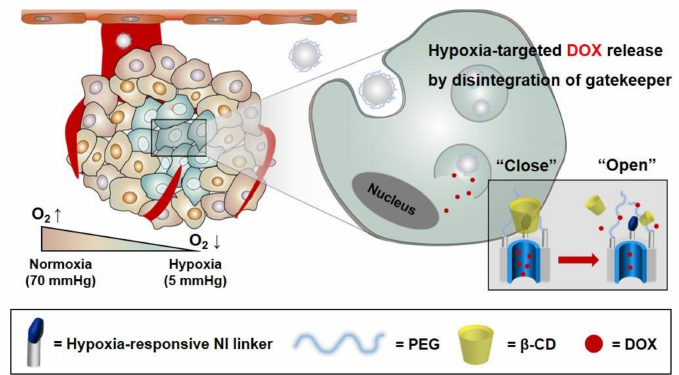
Figure 1. Schematic representation of doxorubicin-loaded hypoxia-responsive mesoporous silica nanoparticles with a β -CD gatekeeper (DOX-CD-HR-MSNs) for DOX delivery.